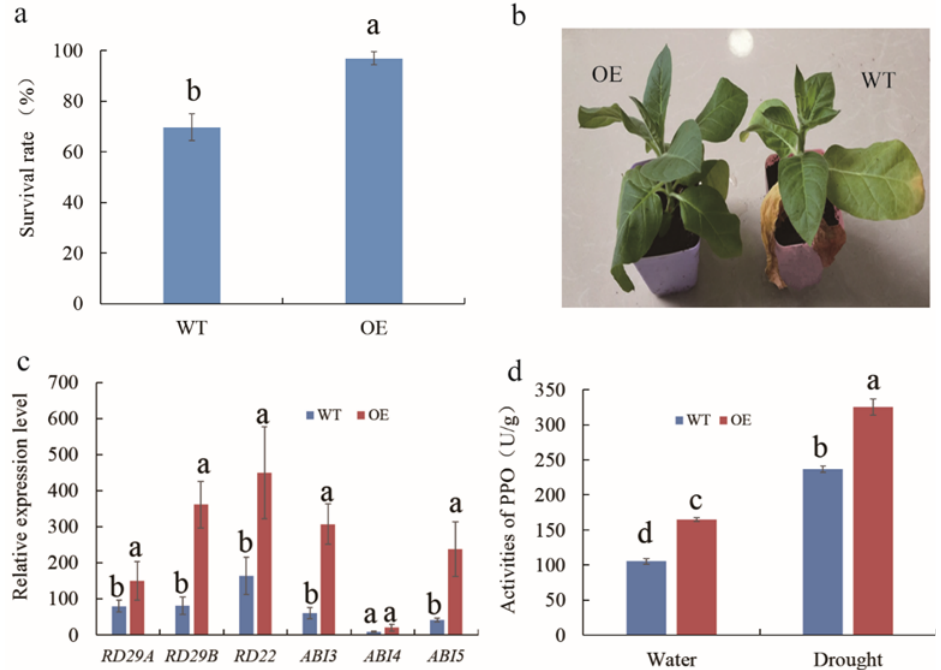
Figure 6. Drought tolerance experiments. ( a ) Survival rates of wild-type and MnMYB3R1 - overexpressing transgenic tobacco plants under drought stress conditions; ( b ) phenotypes of wild-type and transgenic tobacco plants under drought stress conditions; ( c ) expression patterns of ABA signaling pathway-responsive genes in wild-type and transgenic tobacco plants under drought stress conditions; ( d ) polyphenol oxidase activities in wild-type and transgenic tobacco plants under well-watered and drought stress